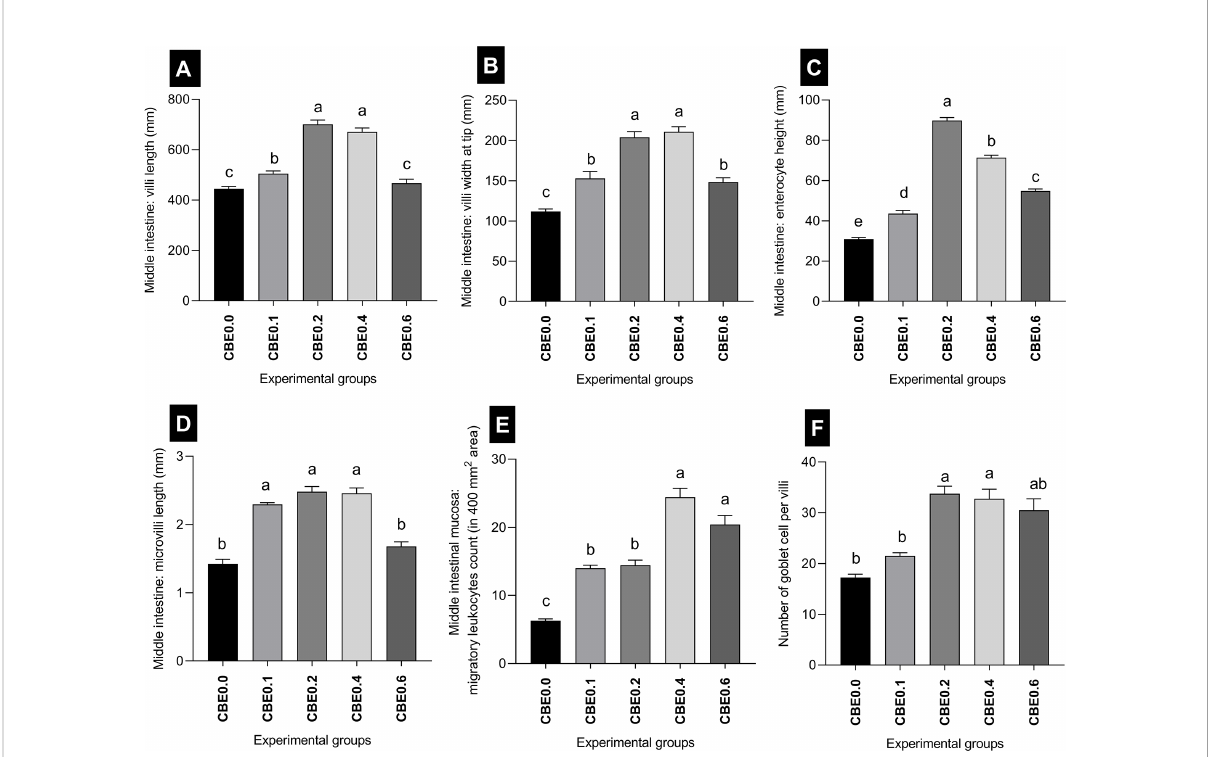
FIGURE 12 Morphometric analysis of intestine in Nile tilapia groups fed different doses of CBE for 10 weeks. (A) The mean length of the intestinal villi (mm) in the middle intestine. (B) The middle intestine villi width at the tip. (C) Enterocytes high at the middle intestine. (D) Microvilli length at the middle intestine. (F) Migratory leukocyte counts in a 400-mm 2 fi eld. (E) Number of Goblet cells per villi. Columns with different superscript letters in the same fi gure are signi fi cantly different (p ≤ 0.05) between different